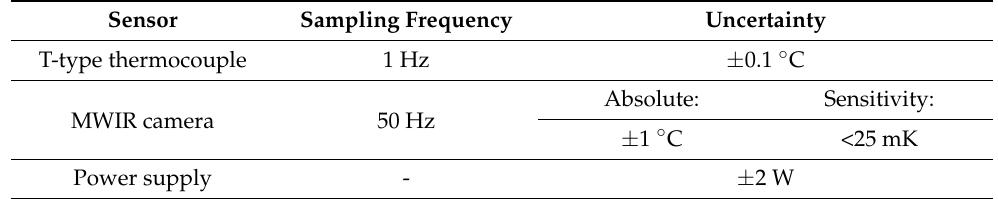
Table 1. Uncertainty of the experimental equipment.